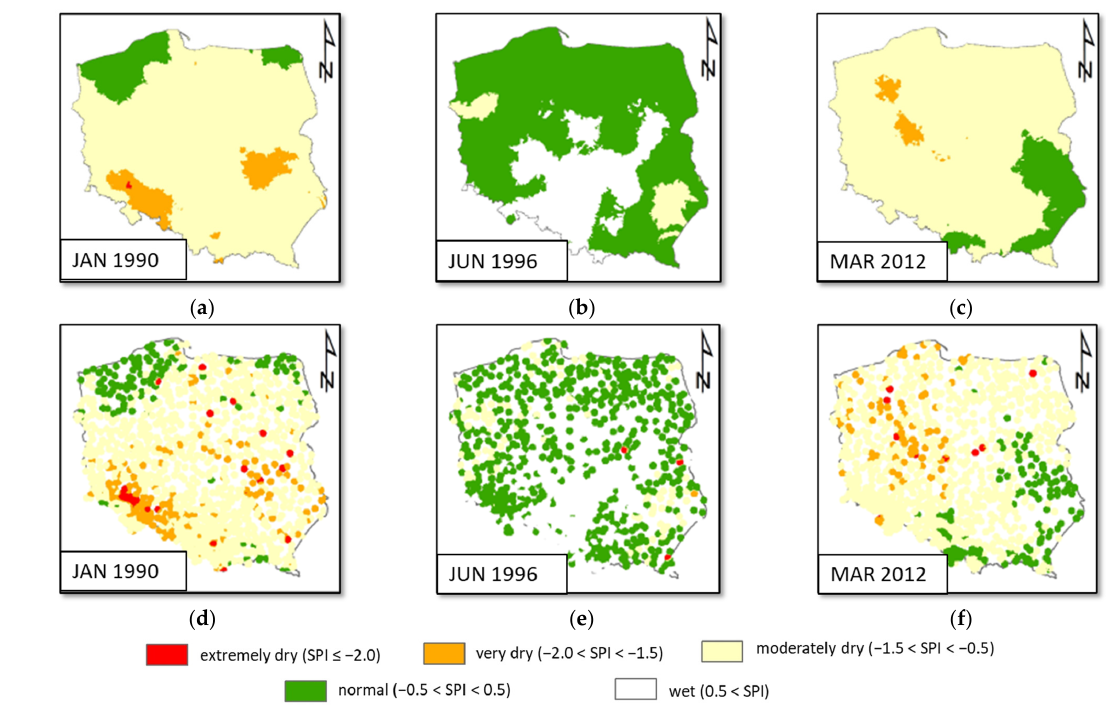
Figure 10. Examples of Kriging method results: in the top row, ( a – c ), results with parameters calibrated to obtain interpolation compatible with those of the other methods, in the bottom row, ( d – f ) interpolation with default parameters, ( a , d ) January 1990, ( b , e ) June 1996, ( c , f ) March 2012.